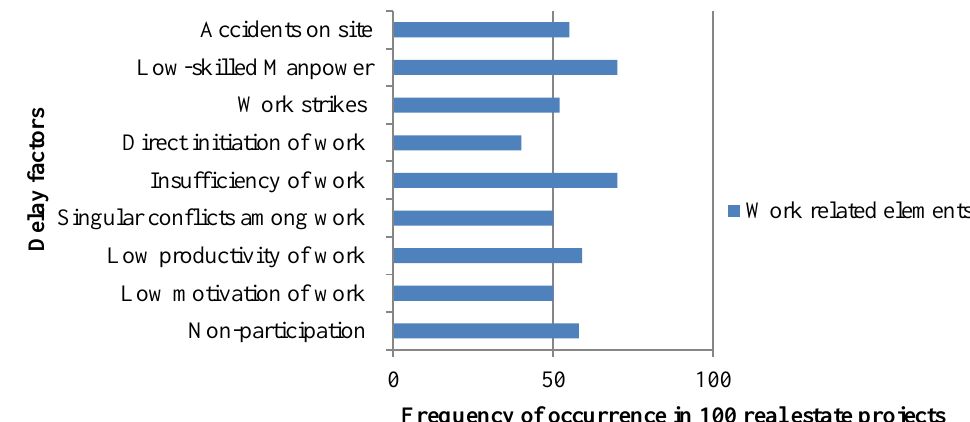
Fig. 7. Frequency of labour-related delay factors [figure made by